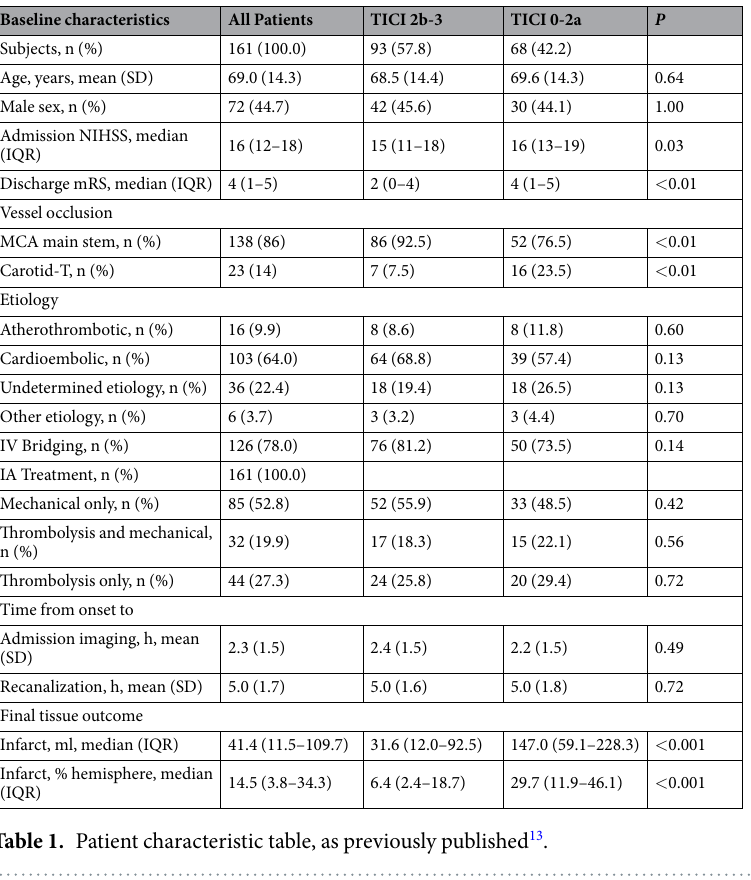
Perfusion parameter